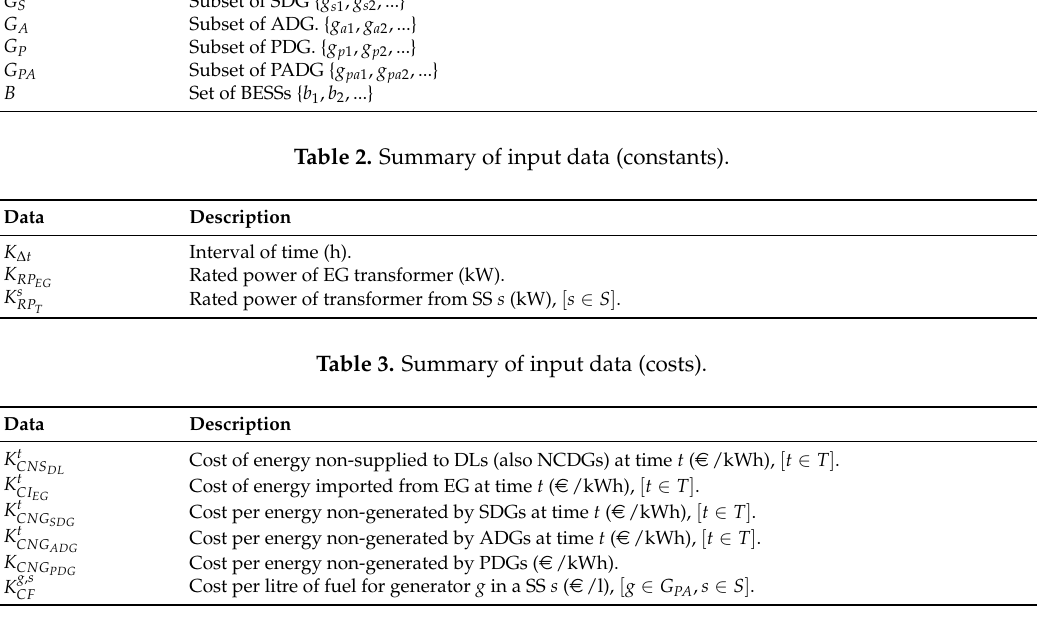
Table 4. Summary of input data (DL